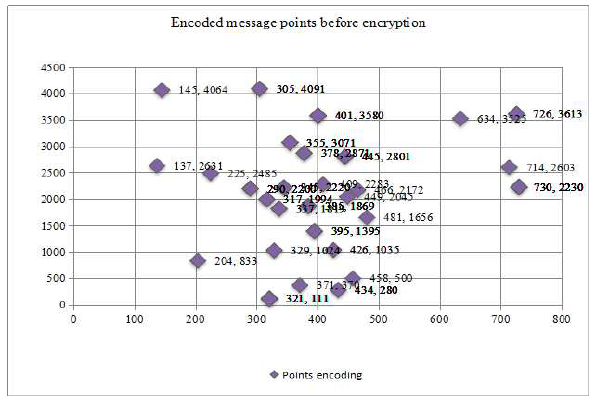
Figure 5. Encoded-points for mentioned plain-message